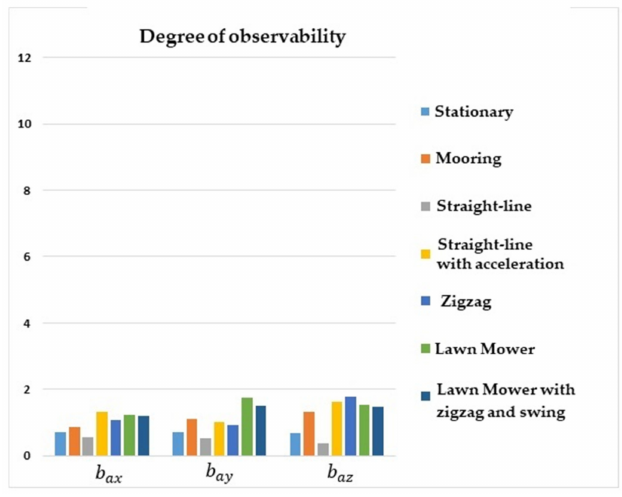
Figure 3. Degrees of observability of the accelerometer biases. INS/GPS/DVL/PS